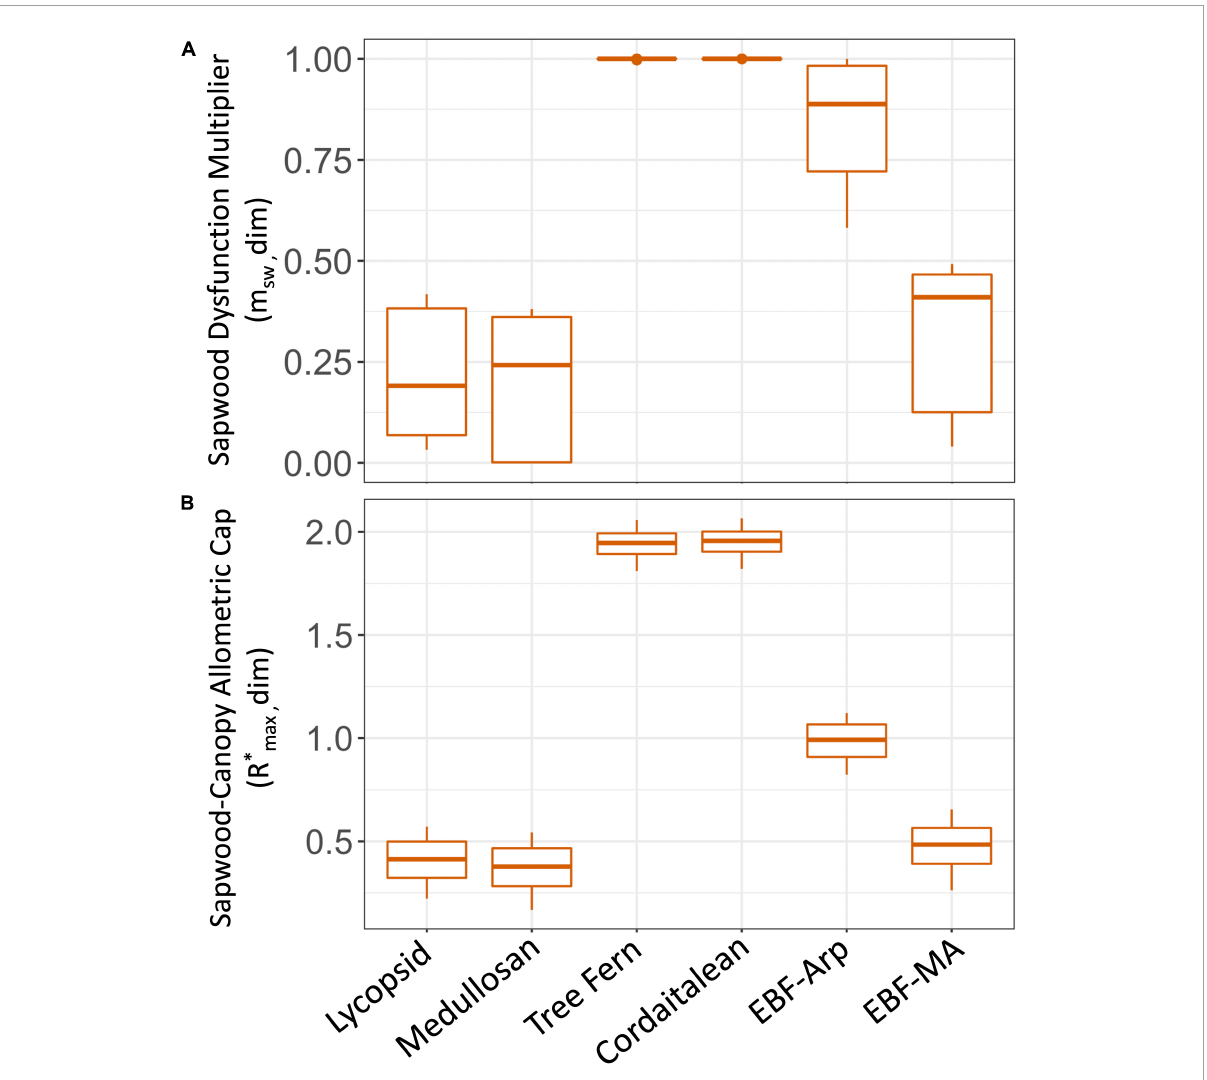
FIGURE8 Simulated sapwood dysfunction responses as represented in Paleo -BGC+. (A) Scalar multiplier (m sw ) used to reduce stomatal conductance in proportion to loss of xylem conductivity due to air seeding, embolism, and cavitation. (B) Standing biomass allometry as a proportion of assumed sufficient sapwood allometry (R ∗ max ) used to place an upper limit on stomatal conductance (g ∗ s , max = R ∗ max g s , max ). Higher values Boxplot centerline are simulation medians, top and bottom of boxes are first and third quartile, whiskers extend to include outliers, at most to the 150% of the interquartile